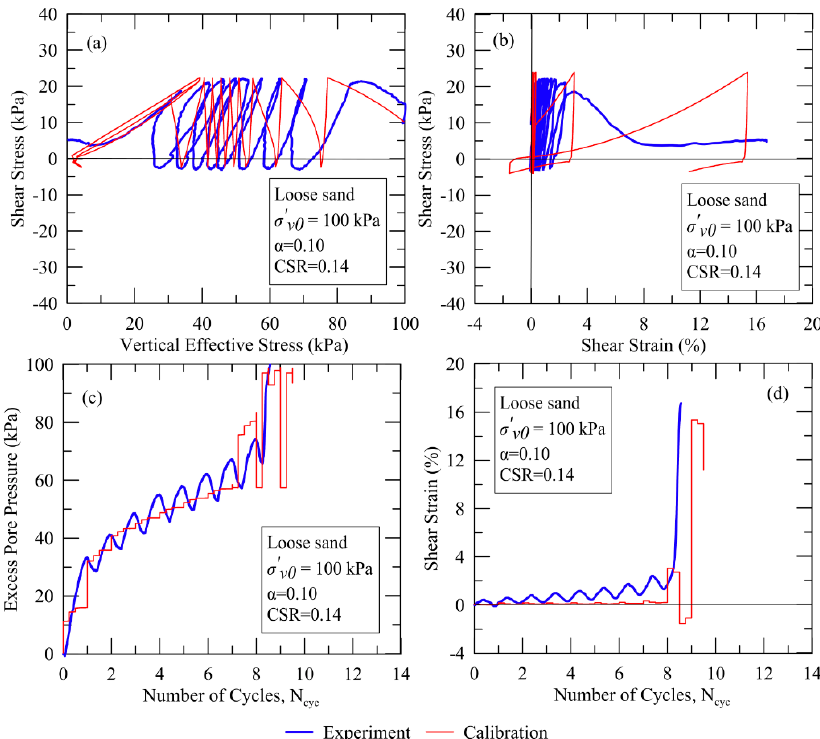
Figure 7. Comparison of the UBCSAND2 model for loose Pohang sand and laboratory CDSS test at CSR = 0.14, σ ´ v0 = 100 kPa, and α = 0.1 in the variations of (a) stress path, (b) shear stress–strain curve, (c) excess pore water pressure generation, (d) shear strain and number of cycles to liquefaction.